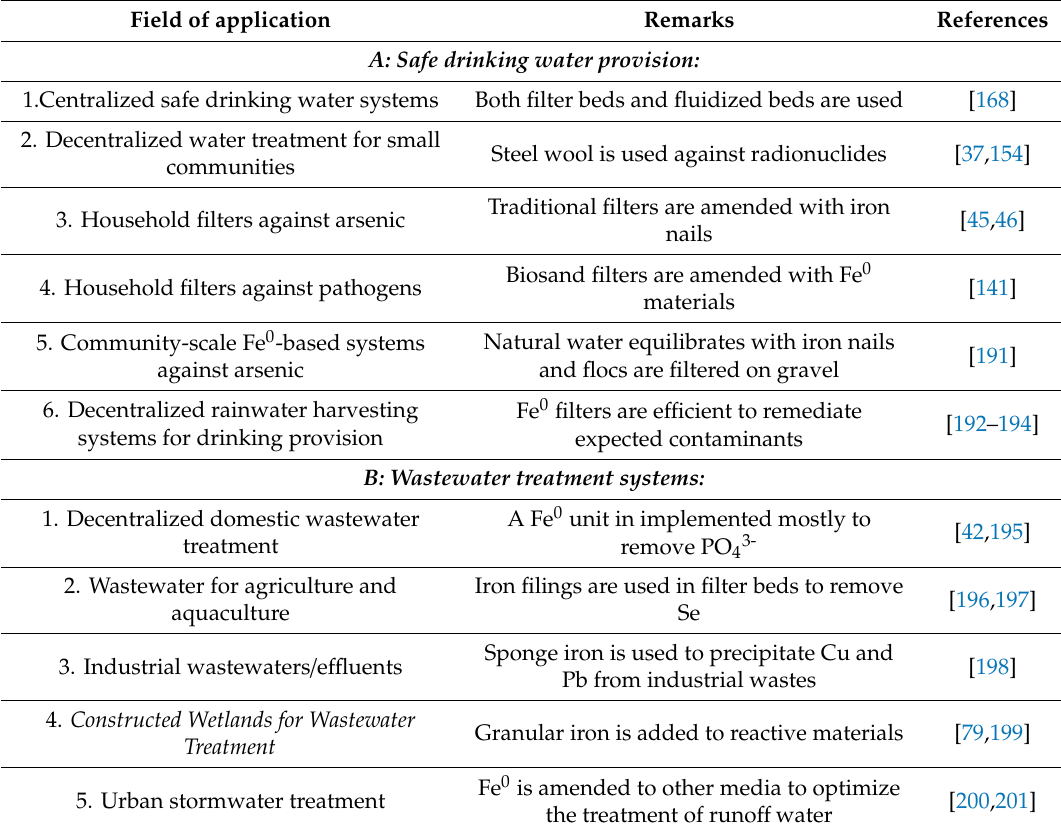
Table 4. Potential field applications of Fe 0 -based systems in drinking water and wastewater treatment. The given reference refers to the oldest known